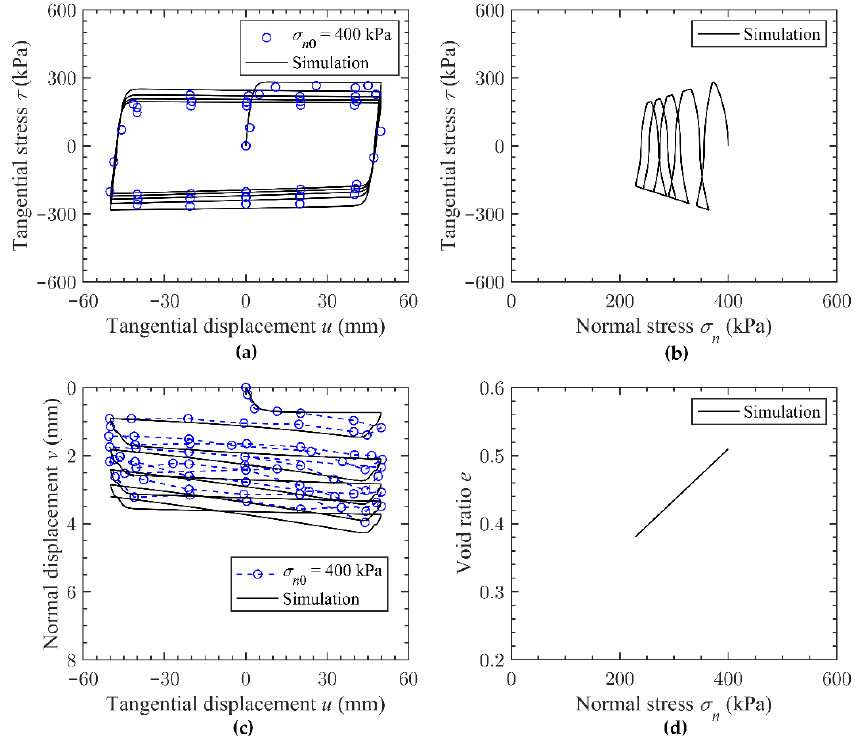
Figure 2. Zipingpu rockfill–steel interface [11] under CNS: ( a ) tangential displacement vs. tangential stress; ( b ) normal stress vs. tangential stress; ( c ) tangential displacement vs. normal displacement; ( d ) normal stress vs. void ratio.